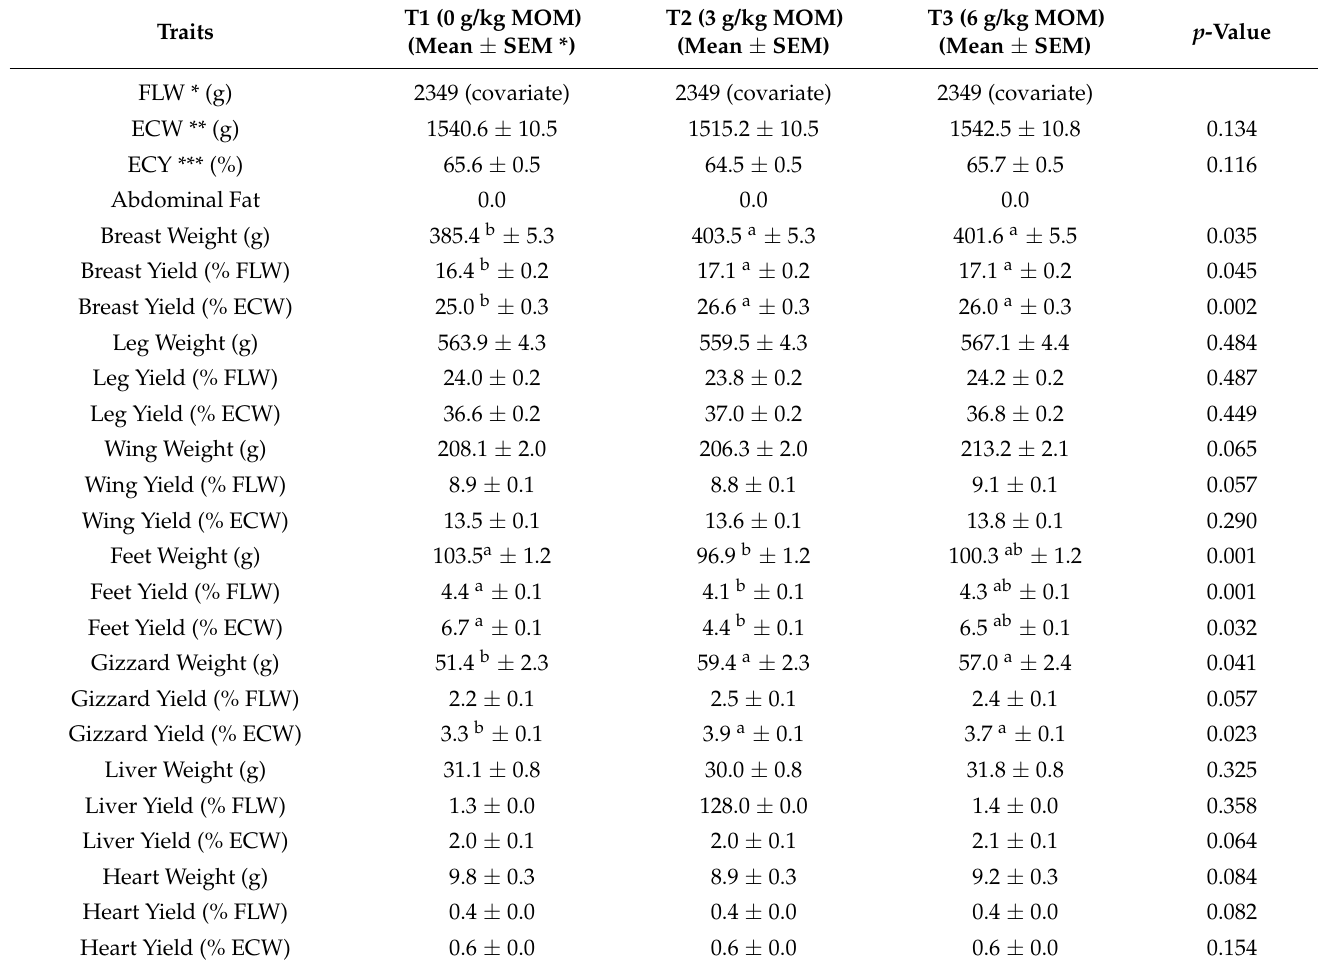
Table 5. Effects of Moringa oleifera meal (MOM) on carcass characteristics of slow-growing Dominant CZ Blue D 107 male chickens raised with outdoor access in a tropical